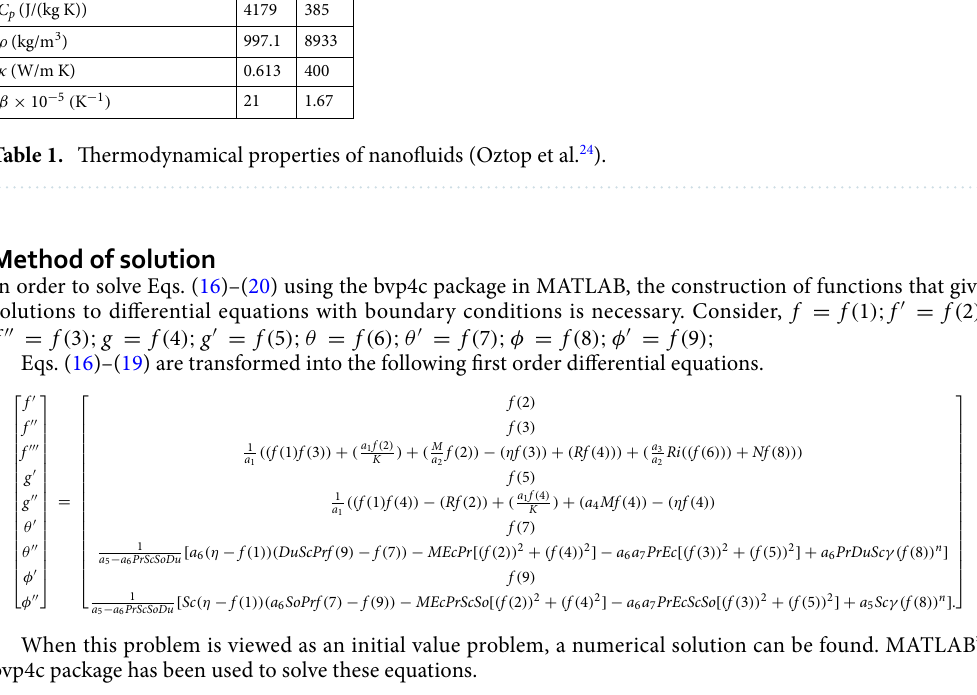
Thermodynamical